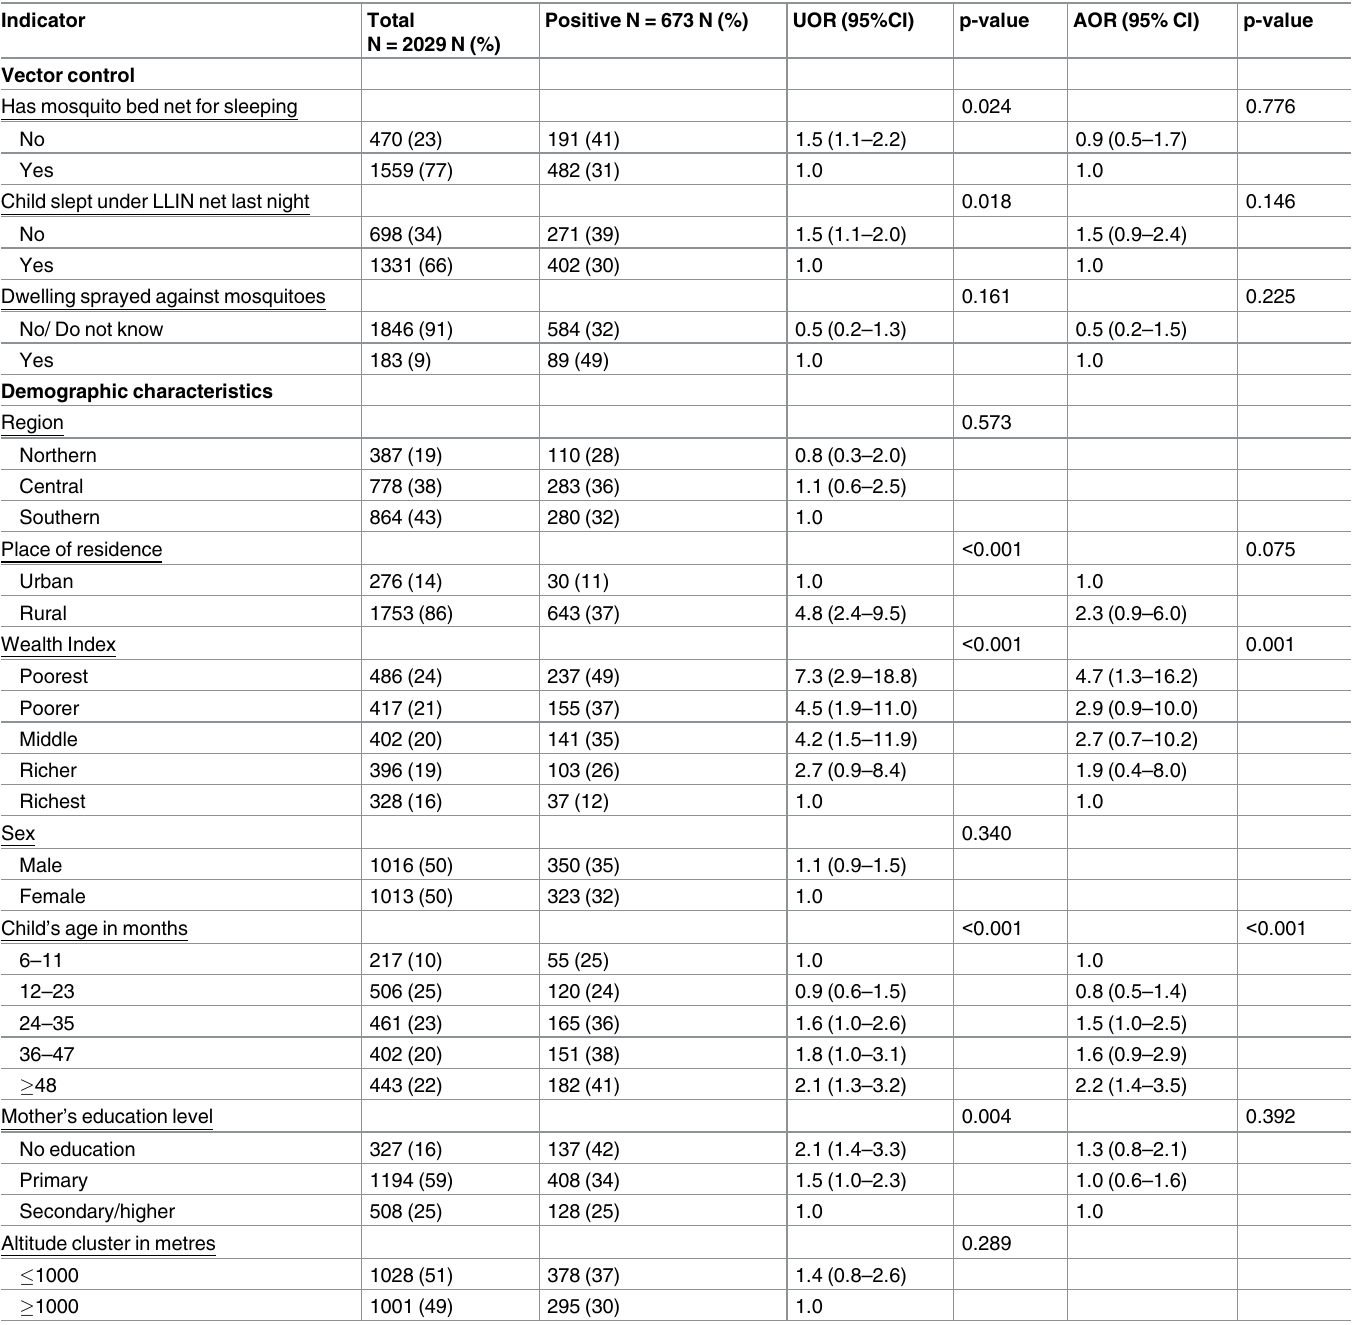
Table 3. Factors associated with malaria parasitaemia in 2014